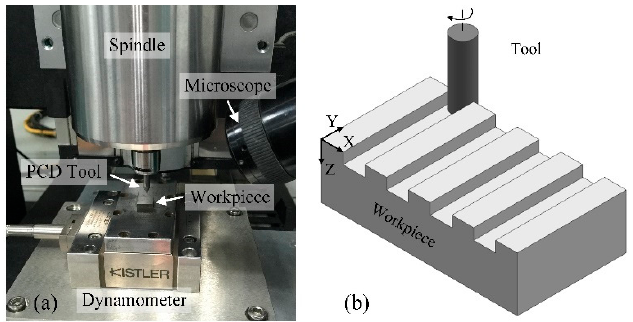
Figure 3. Micromilling of cemented carbide. ( a ) Experimental set-up; ( b ) schematic diagram of groove milling.